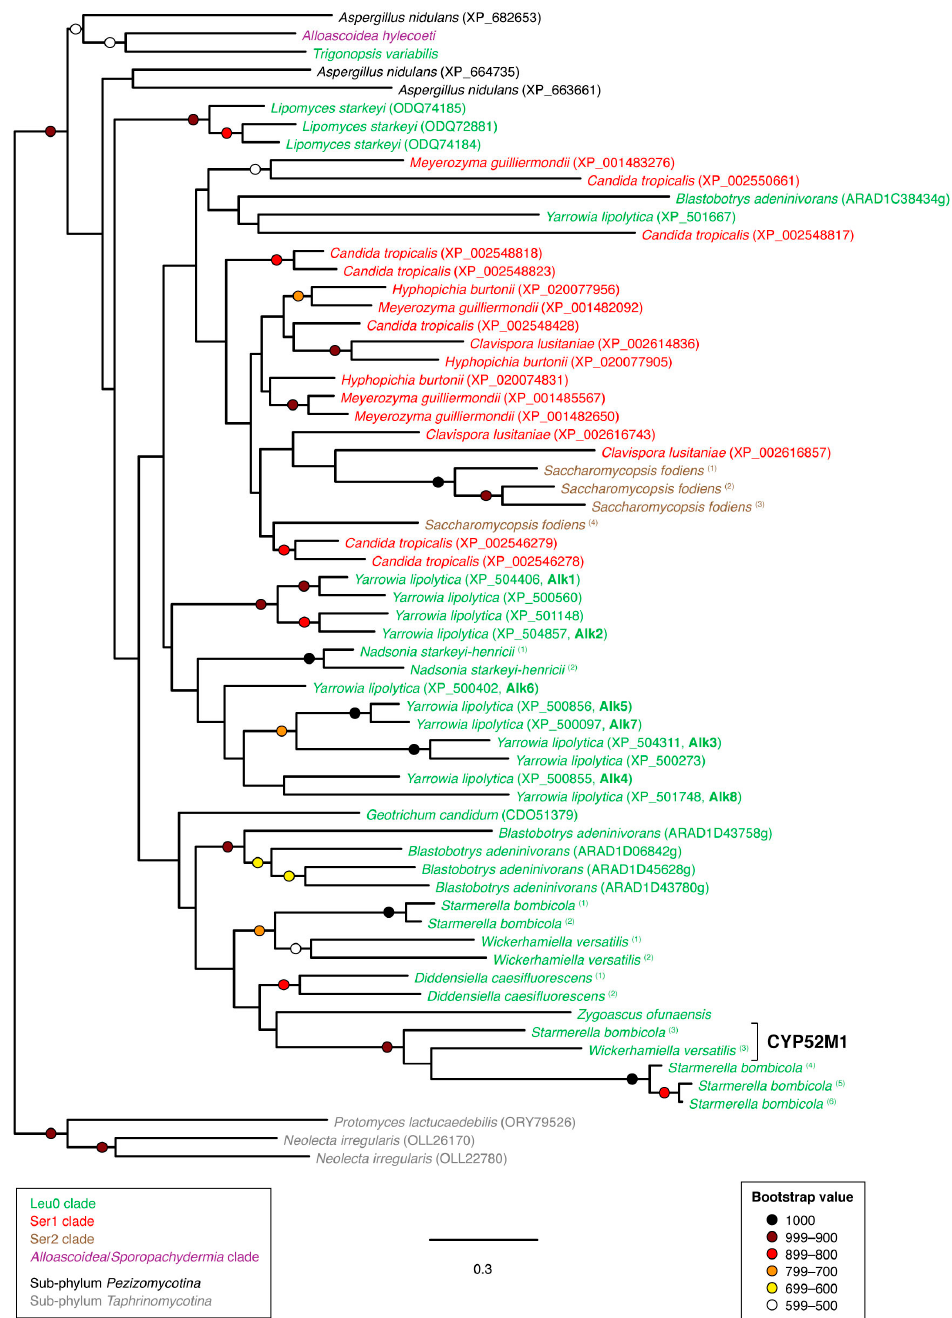
Figure 5. Unrooted phylogram of CYP52 gene products in representative species of sub-phylum Saccharomycotina as well as selected non- Saccharomycotina species. Individual species are color-coded with respect to clade [24]. The analysis was based on 309 aligned amino acid positions of the corresponding proteins. Colored circles represent branch support with the color indicating the proportion of retained nodes among 1000 bootstrap replicates. Branches lacking circles indicate branch support less than 500. Accession numbers for individual protein sequences are displayed when available. Protein sequences lacking accession numbers were derived through conceptual translation of genomic sequences. Named protein sequences are indicated in bold font. (Genomic coordinates for protein sequences derived through conceptual translation of genomic sequences are listed in Table A1 of Appendix